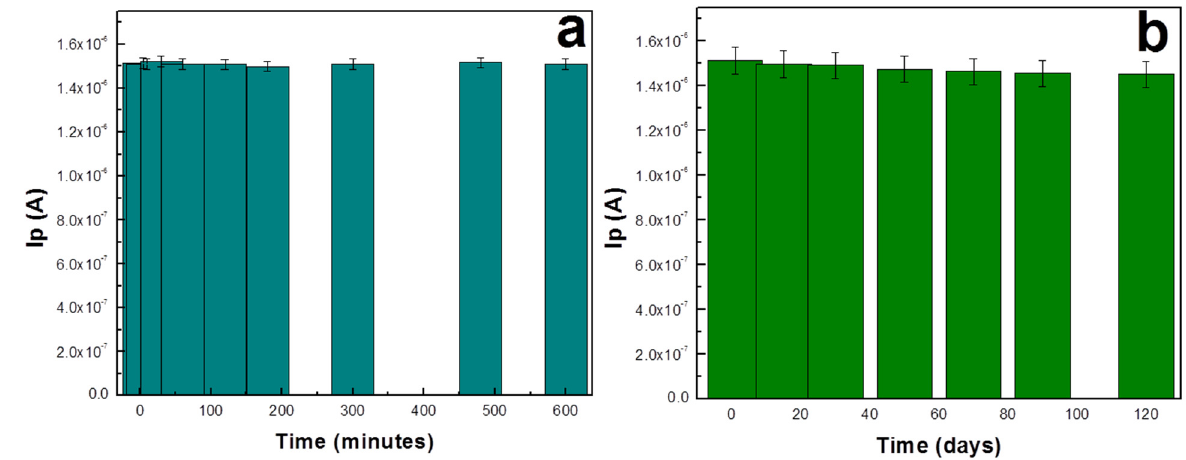
Figure 13. Intra- ( a ) and interday ( b ) DPV response of EGr/GC-modified electrode recorded in pH 5 acetate containing 6 × 10 − 5 M AZT.